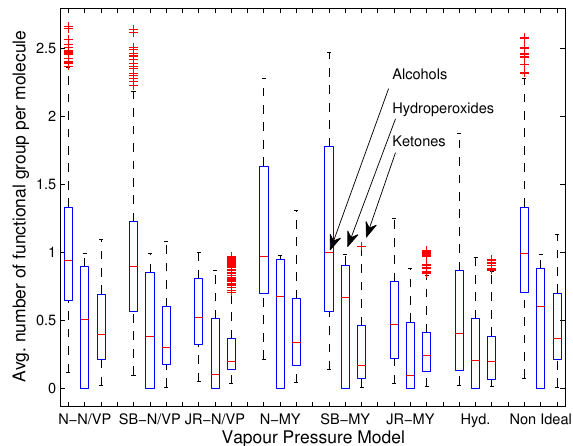
Fig. 8. Box-whisker plots showing the sensitivities of the average number of the three most abundant functional groups (alcohols, hy- droperoxides and ketones) per molecule, across all cases for 27 sce- narios using the partitioning model with (a) five vapour pressure estimation methods (plots 1–5, 2742 compounds, γ i = 1); (b) plot 6 shows the effect of hydrolysis of acid anhydrides (2727 MCM com- pounds, p 0 by N-N/VP, γ i = 1); (c) plot 7 shows the sensitivity to non-ideality (2742 compounds, p 0 by N-N/VP, γ i by UNIFAC). SOA with an average of more than 2.5 alcohols per